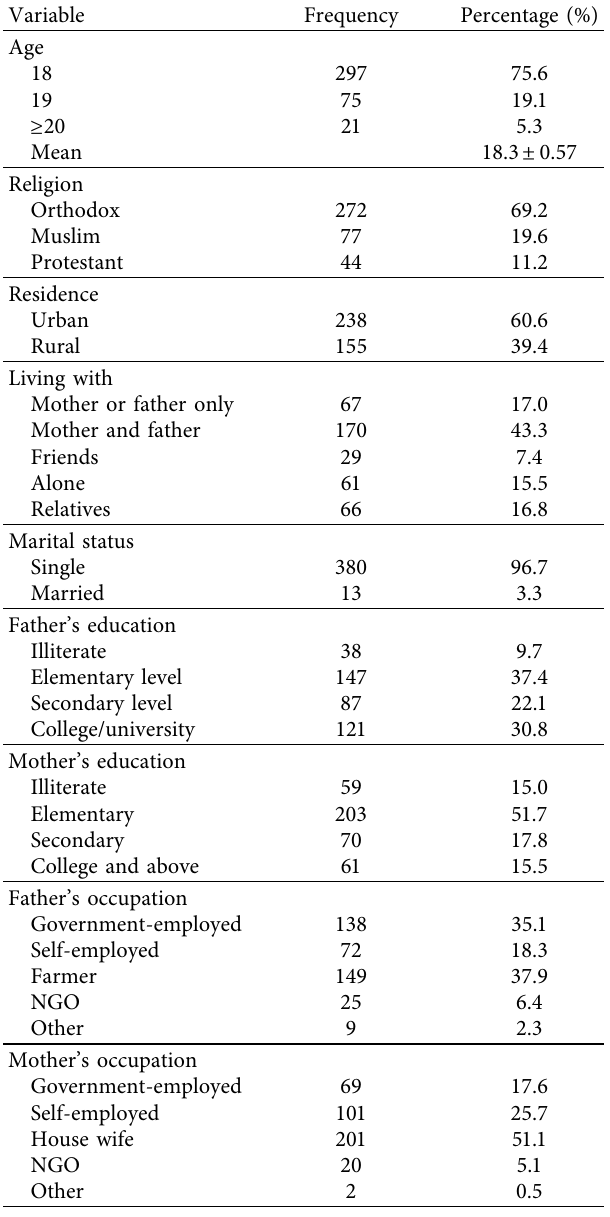
Table 1: Sociodemographic characteristics of preparatory school female students, Assela, Ethiopia, in